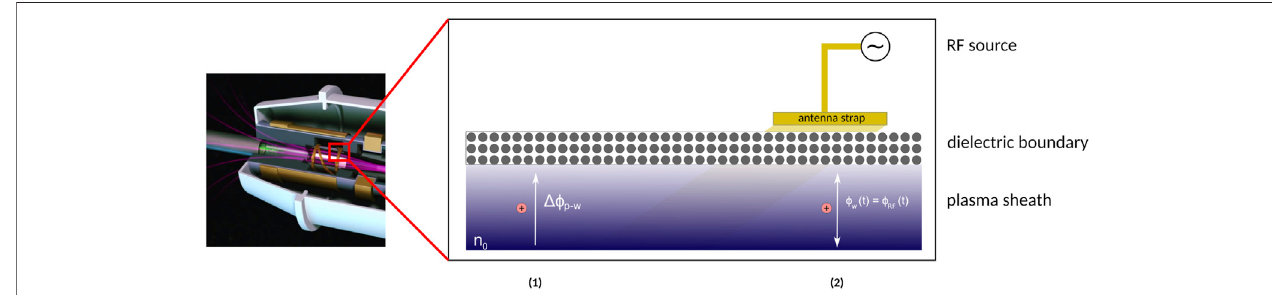
FIGURE 8 | Representation of the two main sputtering regimes present in helicon plasma sources, as previously reported in literature. (1) shows the conditions presentattheboundarybetweenthebulkplasma,withdensity n 0 ,andtheinternaldielectricboundarieswithinanHPS.Parameterssuchasthisdensityandtheelectron temperature T e de fi netheconditionspresentwithintheplasmasheath,whichacceleratethepositiveionstowardsthewallthroughtheplasma-wallpotential ΔΦ p − w [35]. Iftheenergyobtainedbytheionsatthematerialboundarysurpassesthethresholdenergy E thr ,sputteringwillthenoccur. (2) describesthesituationparticulartothe areas under the antenna straps, which may be subjected to high capacitive voltages driven by the external RF subsystem [60, 70, 73]. Given suf fi ciently large voltages, thenegativepartoftheantenna ’ sRFcyclewillacceleratetheionstowardsthesurfacewithenoughtimetotraversethesheath,essentiallybehavingasahigh-voltageDC sheath [60]. Once again, if the energy obtained by the ions surpasses the threshold limit, sputtering will